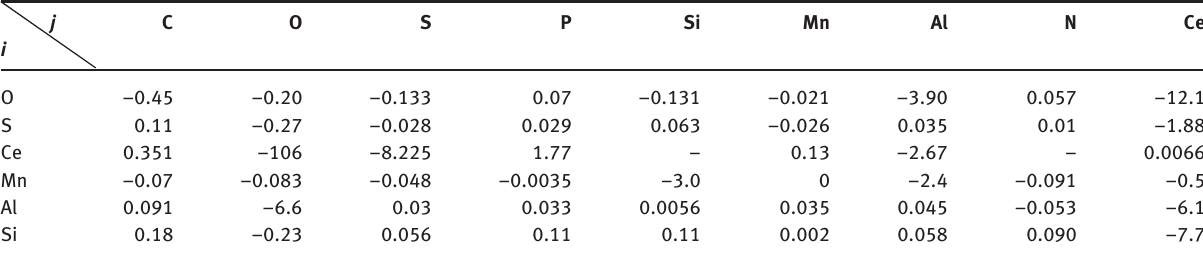
Table 5: The values of e j i for liquid iron at